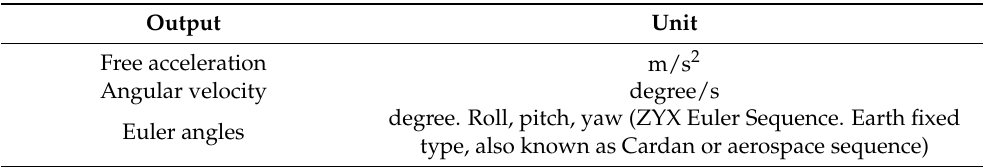
Table 1. Inertial and orientation data outputs of Xsens DOT sensors. Output Unit Free acceleration m/s 2 Angular velocity degree/s Euler angles type, also known as Cardan or aerospace